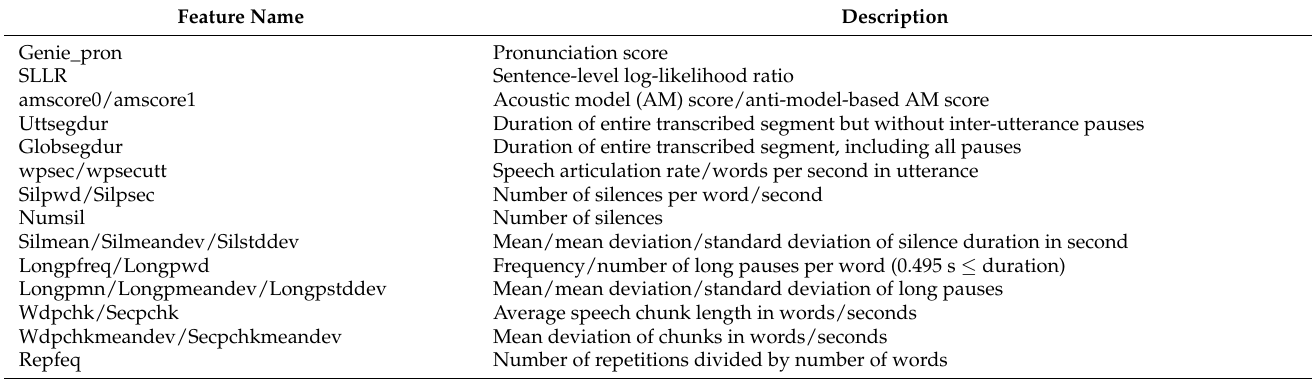
Table 6. Features for the proficiency scoring